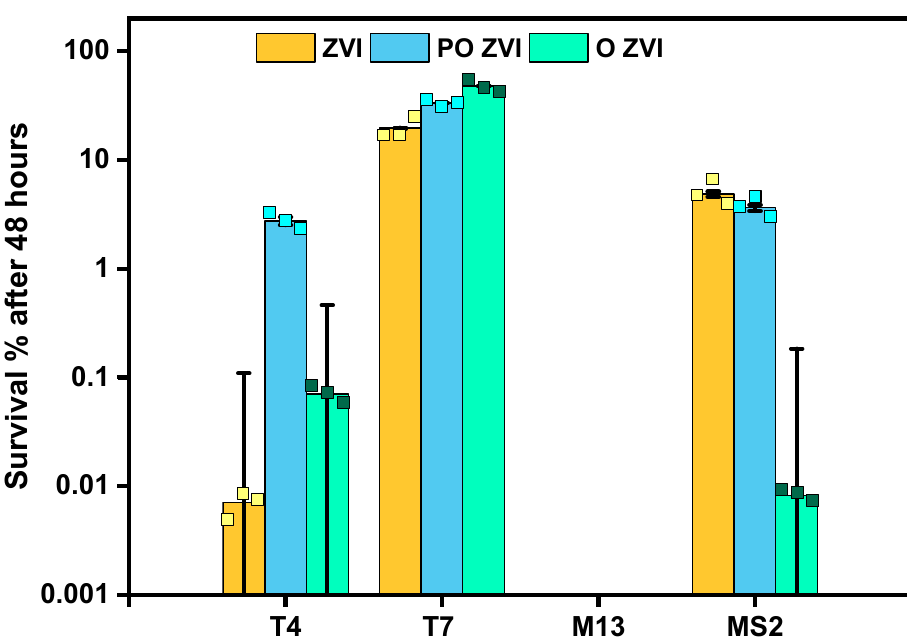
Figure 3. 48 h experiment of bacteriophages in the presence of ZVI, PO ZVI, and O ZVI, all at a concentration of 1 mg/mL. The squares on each bar represent the three biological repetitions and the bar itself is the average. The initial concentration of the phages was around 10 7 PFU/mL in all cases. p values regarding control samples were smaller than 0.001 (***) in all cases.